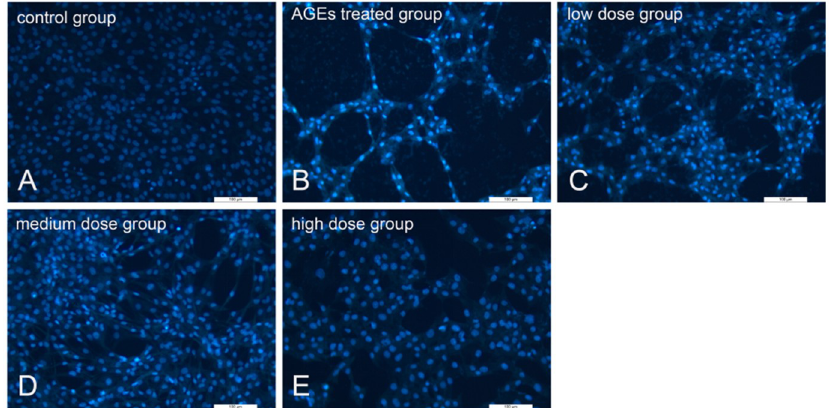
Figure 5. KM treatment prevents apoptosis-related morphological changes in the nuclei of AGE-treated GMCs. Detection of apoptotic morphology using Hoechst 33258 stain in ( A ) control group cells ( B ) cells treated with AGEs (160 μg/mL) for 24 h, and ( C – E ) cells pre-treated with 10, 20, or 35 μM KM and then stimulated with AGEs (160 μg/mL) for 24 h. The photographs were taken directly from culture plates with an inverted fluorescence microscope (magnification 100 × ).